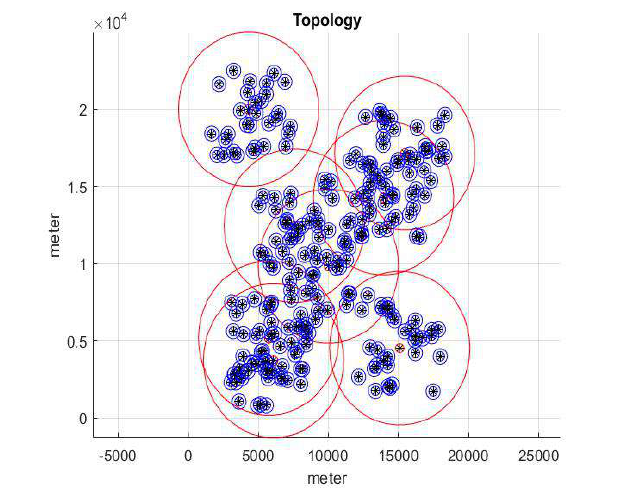
Figure 6. Network topology.